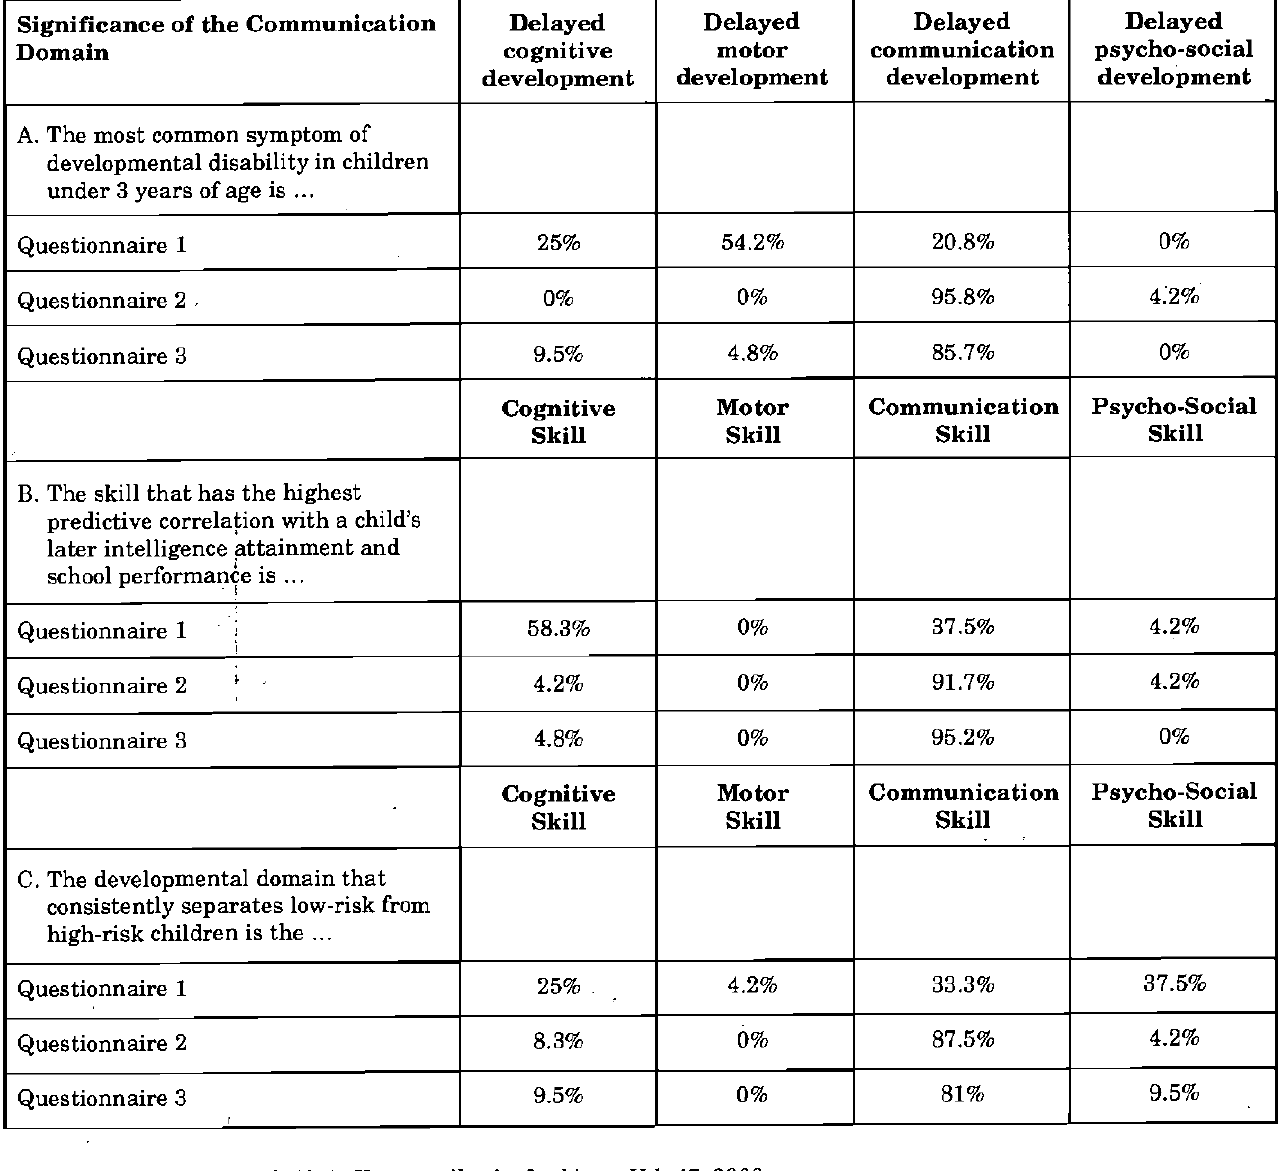
Community nurses' knowledge regarding the significance of the communication domain, as re- flected in the pre- and post-training surveys: (Question Dl) Delayed Significance of the Communication cognitive Domain